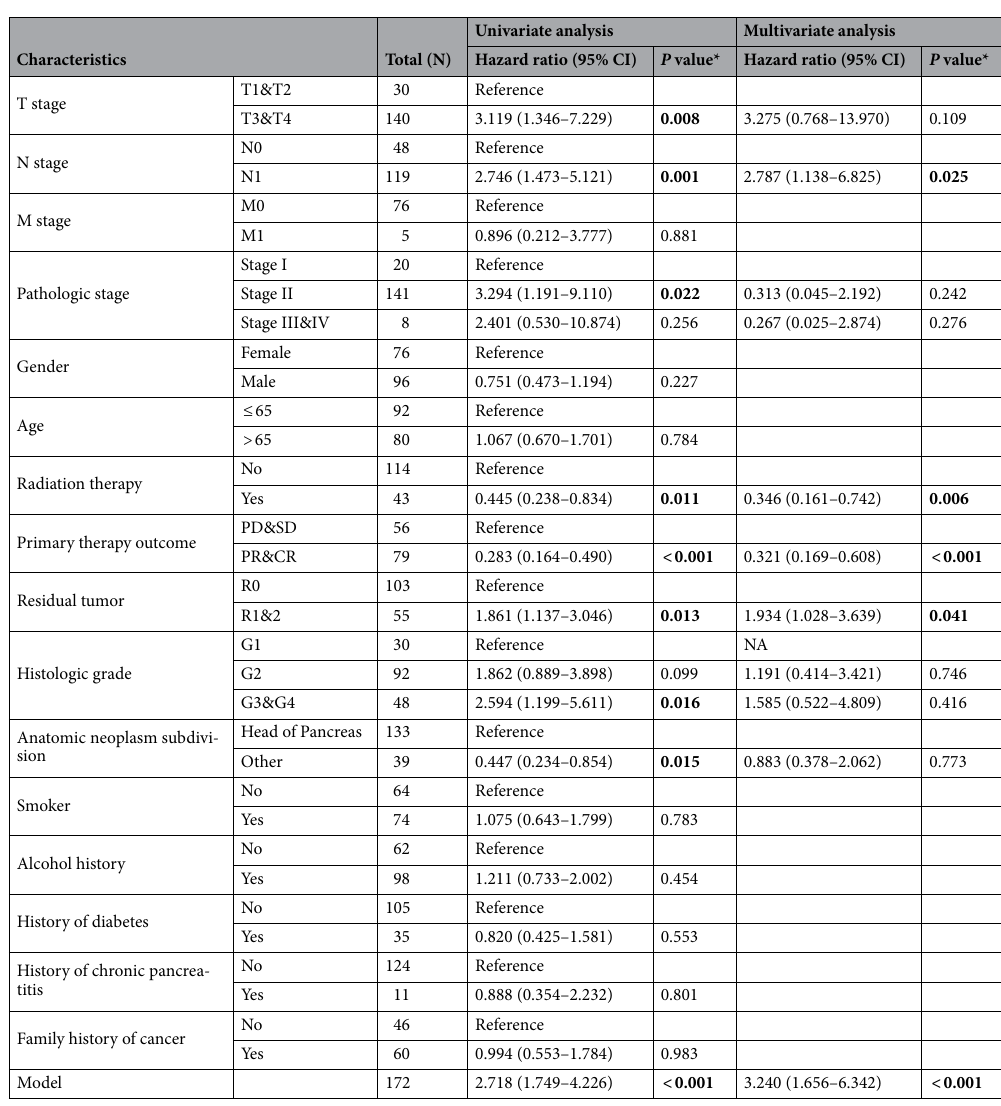
Table 6. The univariate and multivariate analysis for the DSS (TCGA-PAAD). DSS disease specific survival, CI confidence interval, NA reference group or could not be evaluated. *Compared with each group (log-rank test or Omnibus test for univariate, Cox regression analysis with adjusted hazard for multivariate). p < 0.05 means statistically significant (highlighted in